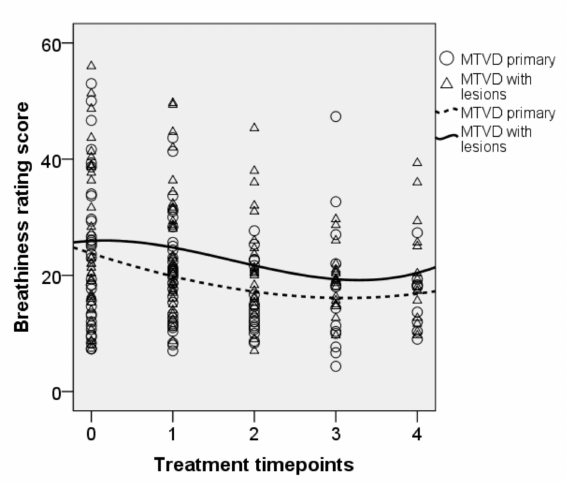
Figure 4. Longitudinal plot of data for the breathiness ratings. Trend line is shown for each subgroup. 0 = baseline, 1 = OPT, 2 = SVQ, 3 = SVQ variant, and 4 =